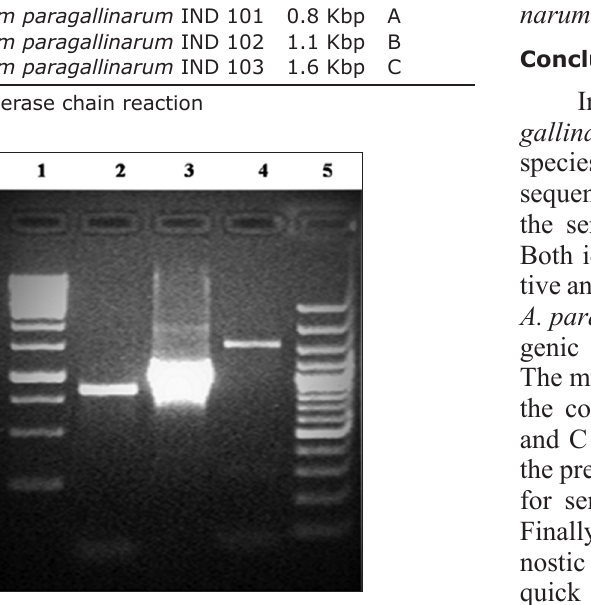
Figure-2: Agarose gel electrophoresis of multiplex polymerase chain reaction products from field isolates of Avibacterium paragallinarum (Lane 1 and 5: Molecular weight markers, Lane 2: Strain IND 101, Lane 3: Strain IND 102, and Lane 4: Strain IND